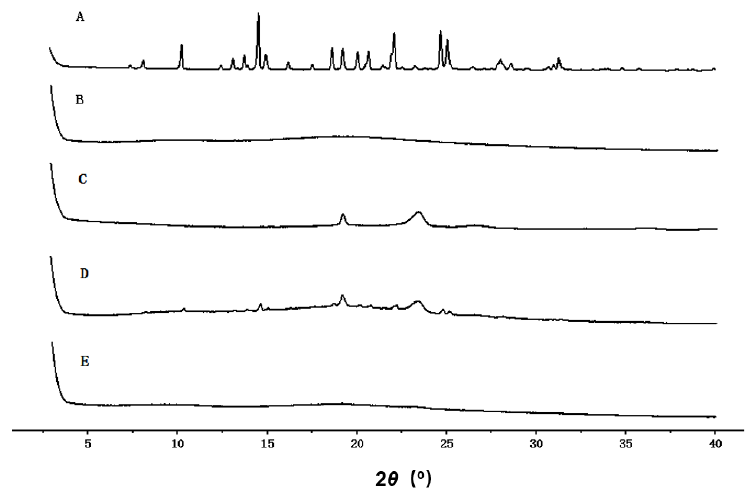
Figure 6. XRD spectrum of PPD ( A ), Soluplus ® ( B ), TPGS ( C ), physical mixture ( D ) and lyophilizates of PPD-S/T-MM-2.0 ( E ).